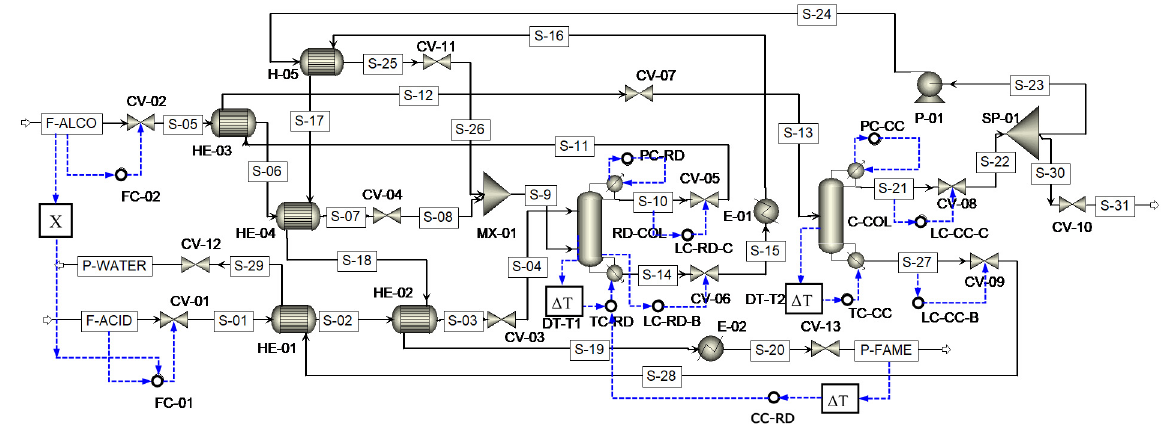
Figure 10. Process flow diagram with control scheme including composition control and feed ratio control used in Cases II and III.